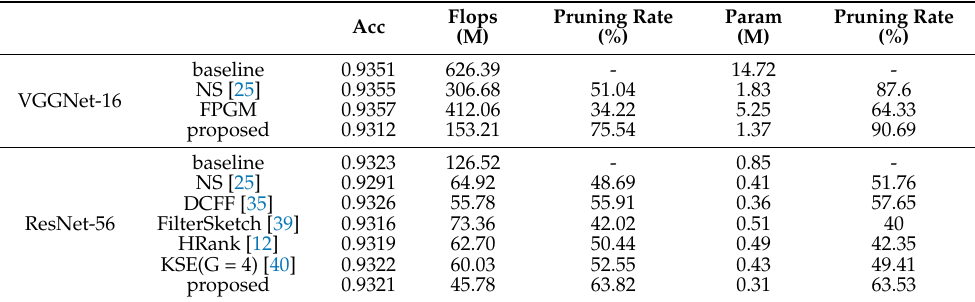
Table 1. Pruning result on CIFAR-10.